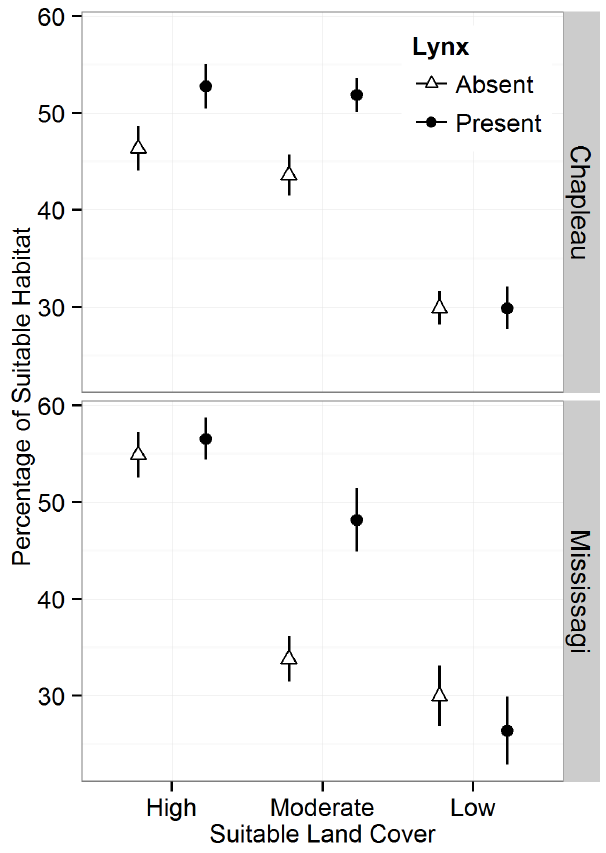
Figure 2. Mean percentage of suitable habitat (with standard errors) for lynx presences compared to pseudo-absences at the 25 km 2 scale in the regions of Chapleau and Mississagi with three levels of suitable land cover.